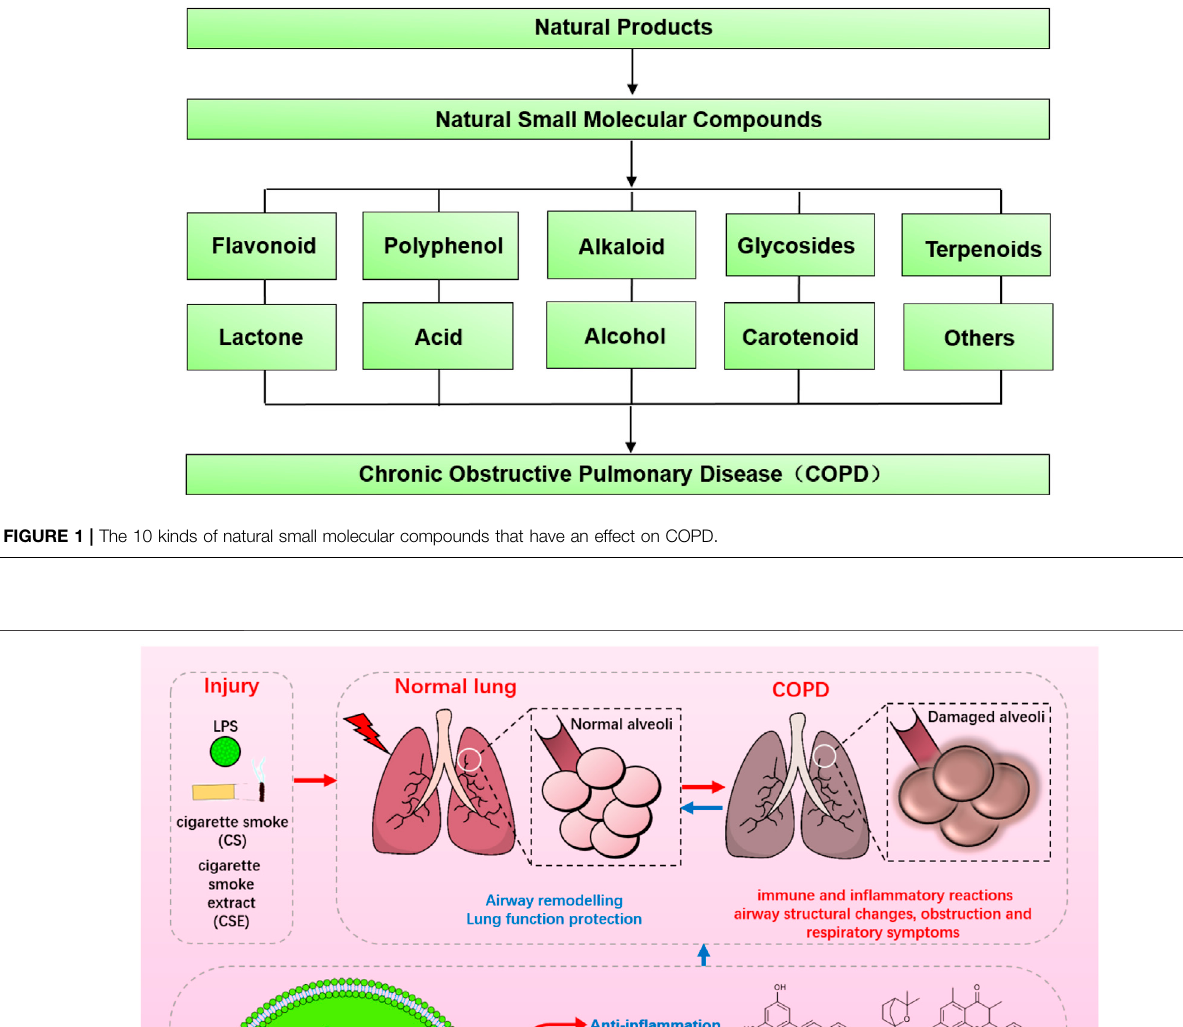
Frontiers in Pharmacology |